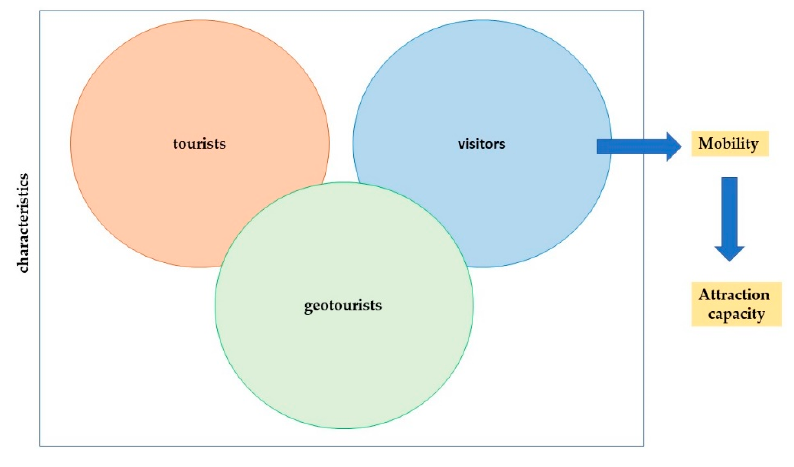
Figure 3. Process